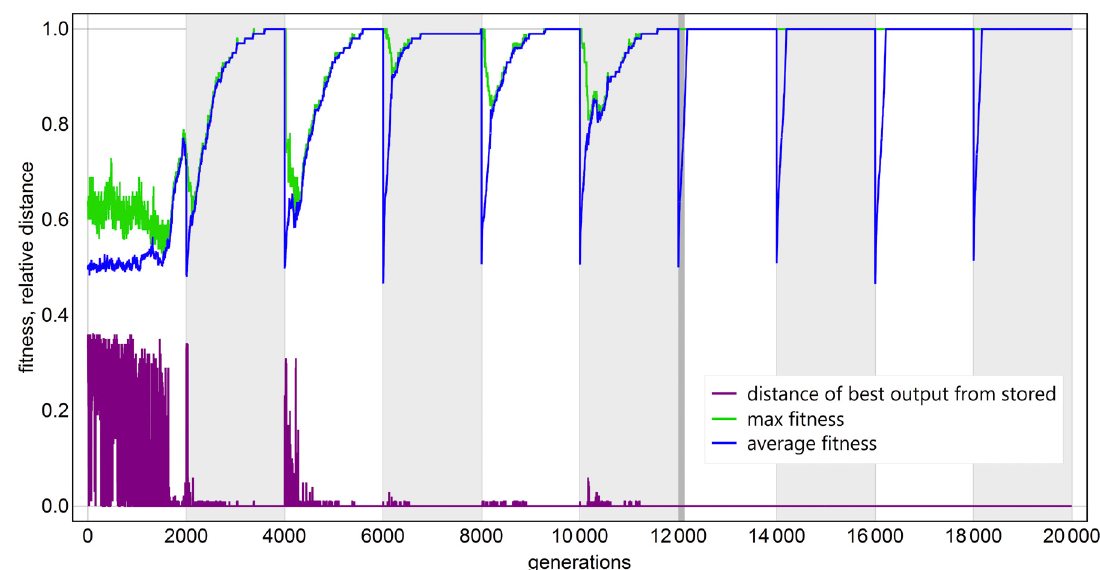
Figure 4. Fitness and recall accuracy over periodically alternating environments. Blue: average fitness; green: best fitness; purple: distance of the best output of the population from the closest one stored in memory (for details, see main text). Grey and white backgrounds represent the changing environment: We alternated two global optimums at every 2000 th generation. After the 12000 th generation, we turned off learning (thick vertical line) and set the input to random patterns after each changing of the environment. Parameters: N N = 100, N = 40, fitness is the relative Hamming similarity to the actual T